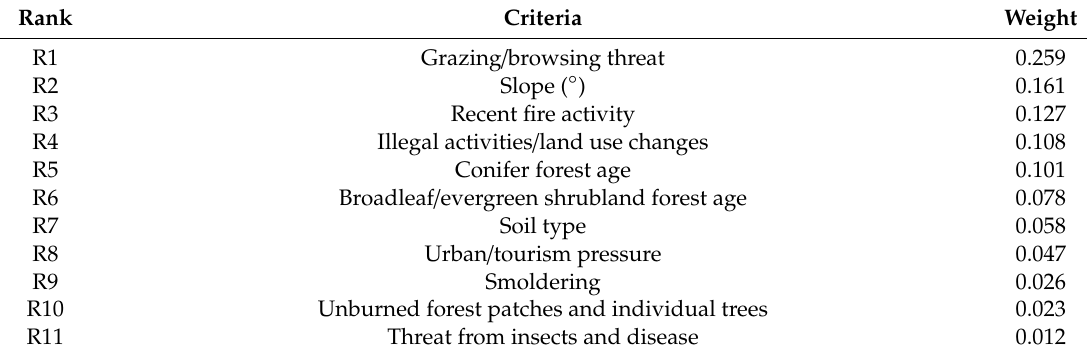
Table A10. Pair-wise comparison reciprocal matrix for the regeneration potential and vegetation recovery fire e ff ects category. RCI: random consistency index; CI: consistency index; CR: consistency ratio; λ max : principal